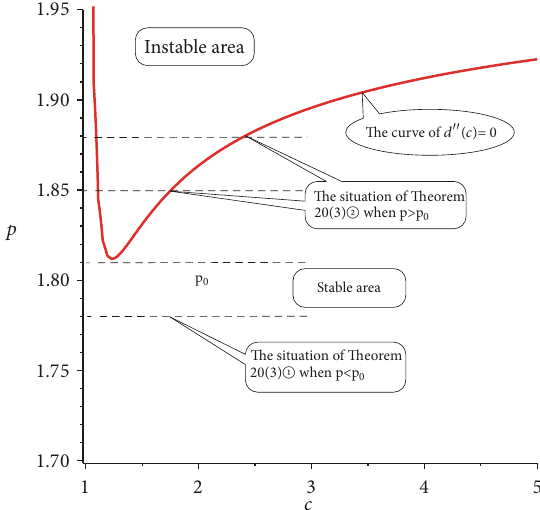
Figure 4: The curve of 𝑑 󸀠󸀠 (𝑐) = 0 when 𝛼 = 1 , 𝛽 = −1 , 𝛾 = 3 , 0 < 𝑝 < 2